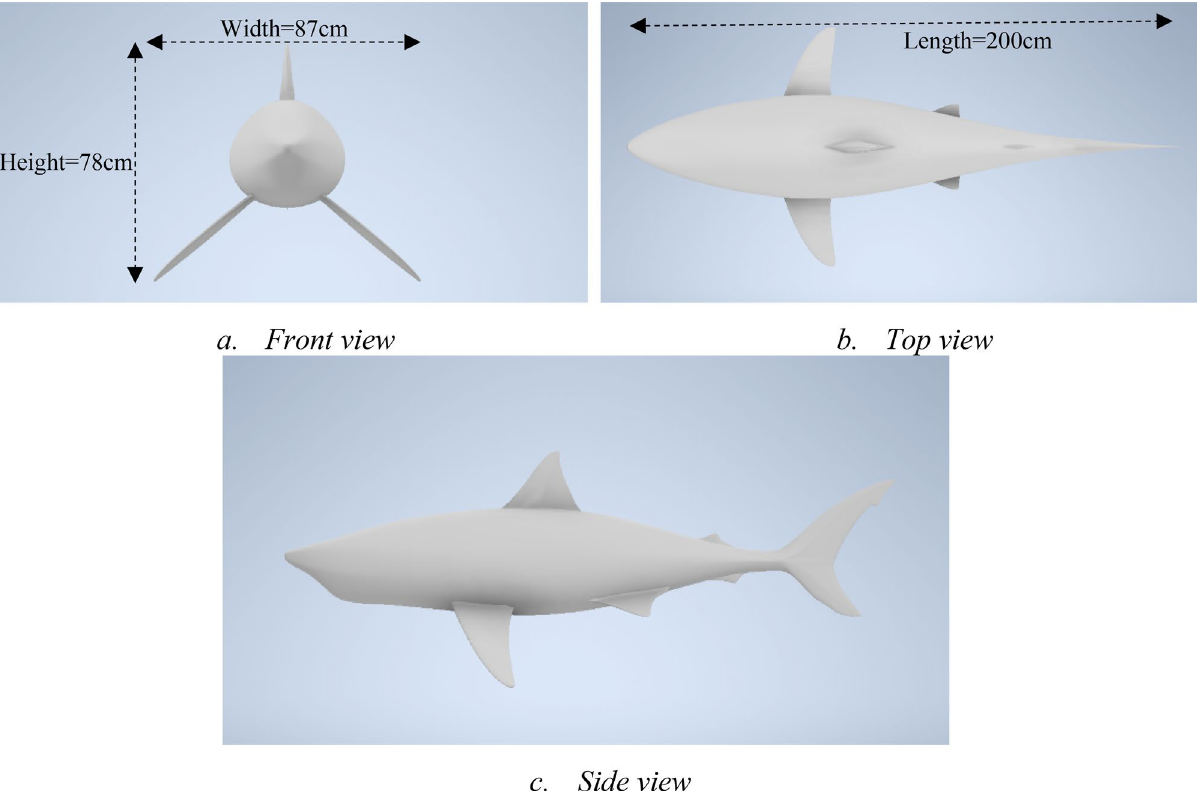
Figure 4. The 3D CAD oceanic whitetip shark model used for CFD simulation (Created using Autodesk Inventor